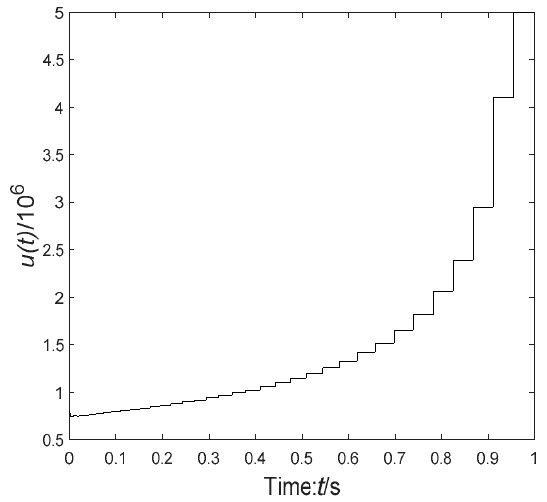
Figure 7. Optimal temperature control trajectory ( N = 20).